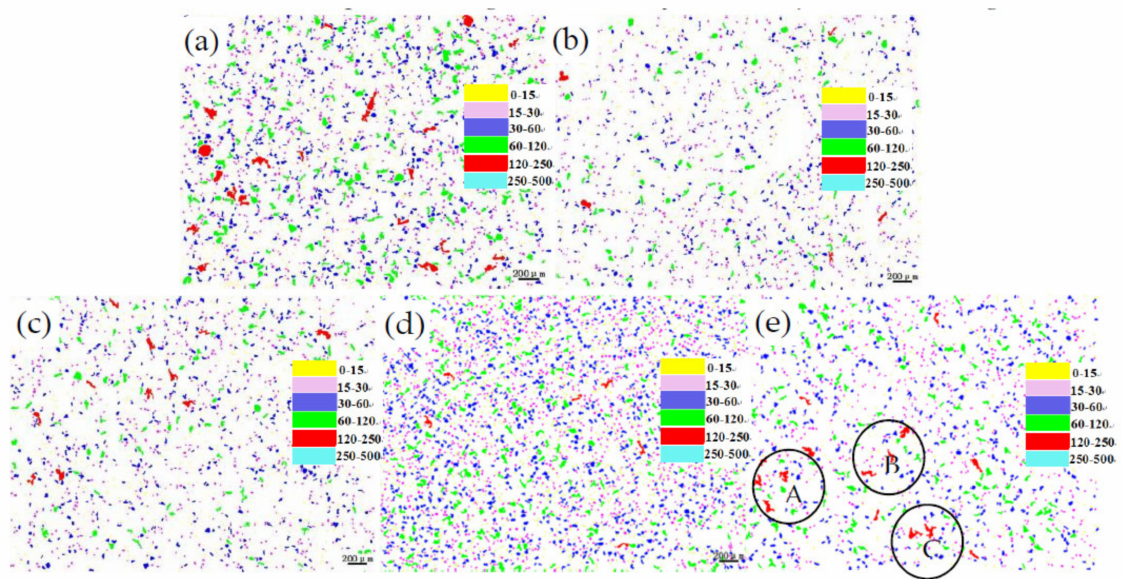
Figure 2. Changes of lead particle size distribution in ZCuPb20Sn5 alloy with different P contents: ( a ) B 0 wt.%, ( b ) B 0.01 wt.%, ( c ) B 0.05 wt.%, ( d ) B 0.1 wt.%, ( e ) B 0.2